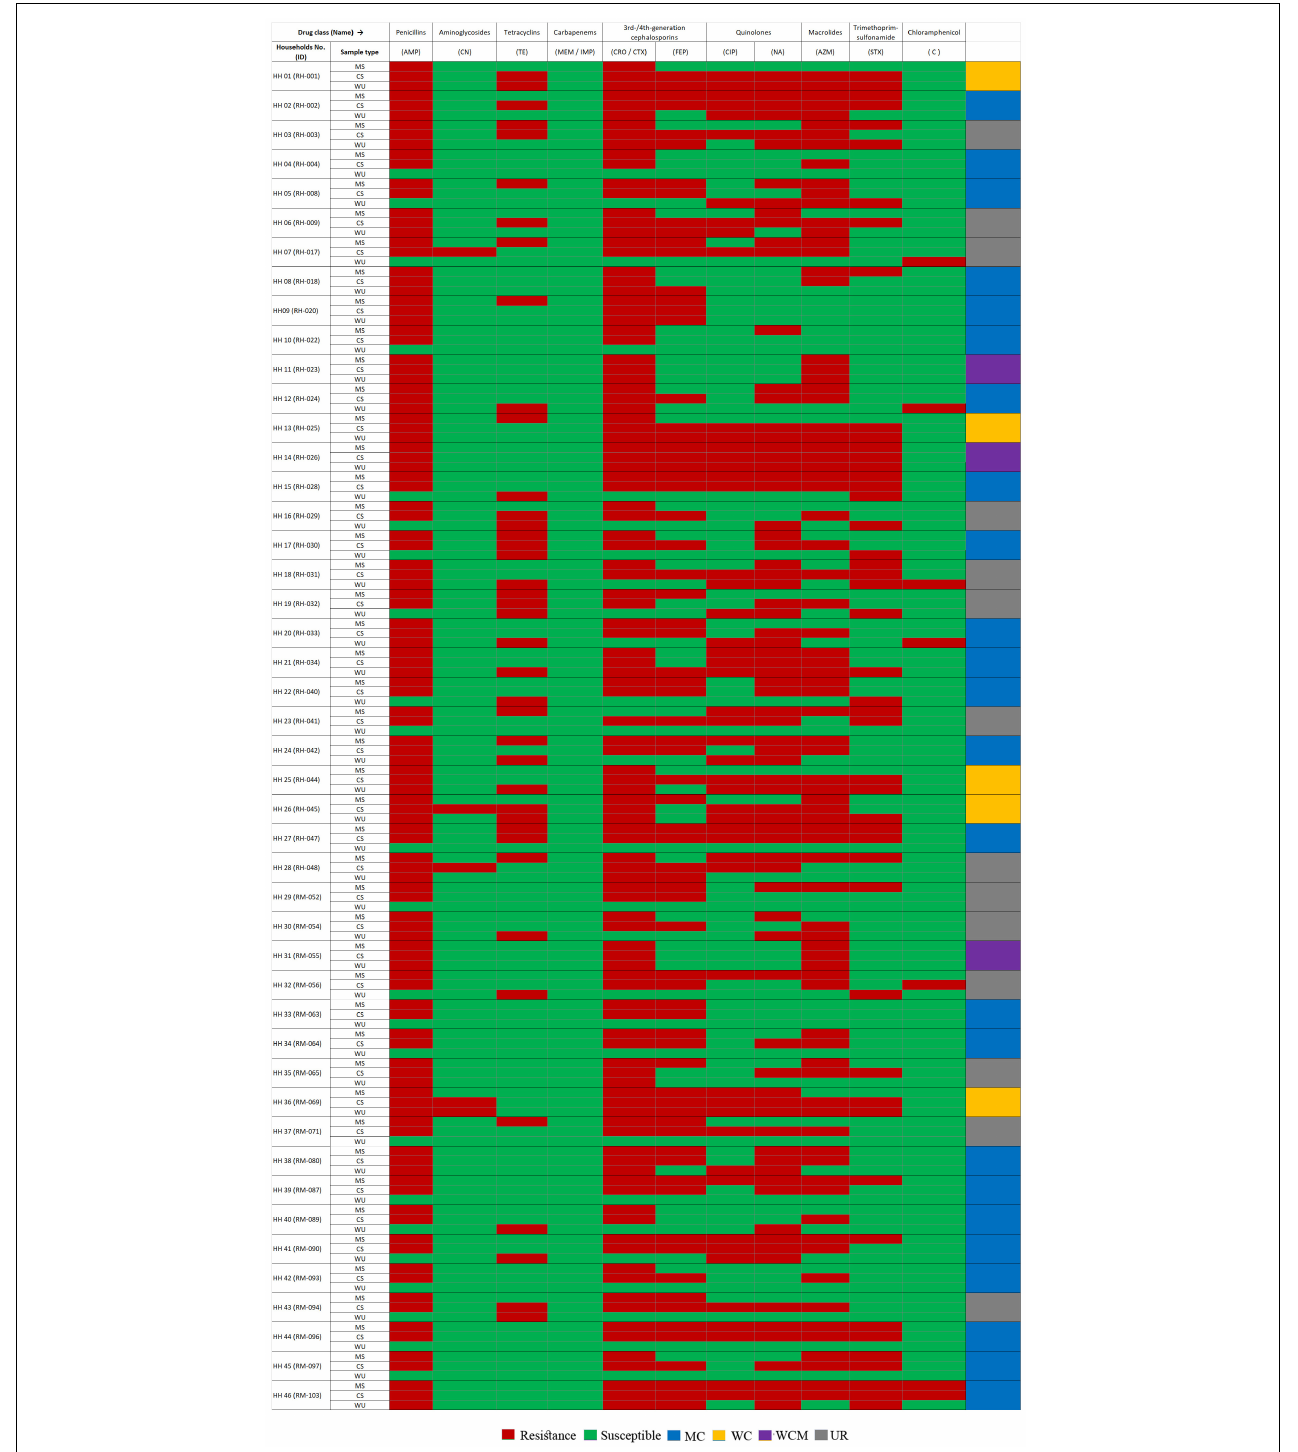
FIGURE 1 | Heatmap showing antibiotic susceptibility (AS) pattern of ESBL-Ec isolated from stool samples of mother–child dyads and point-of-use drinking water samples from 46 households. Amp, ampicillin; CN, gentamycin; TE, tetracycline; MEM, meropenem; IMP, imipenem; CRO, ceftriaxone; CTX, cefotaxime, FEP, cefepime; CIP, ciprofloxacin; NA, nalidixic acid; AZM, azithromycin; STX, trimethoprim/sulfamethoxazole; C, chloramphenicol; HH, households; MS, mother stool; CS, child stool; WCM, AS patterns matched among E. coli isolates from mother–child gut and point-of-use drinking water origin; MC, AS pattern matched between E. coli isolates of mother–child gut origin; WC; AS pattern matched between E. coli strains from child-gut and point-of-use drinking water origin; UR; AS pattern among E. coli strains from all sample sources were diverse.